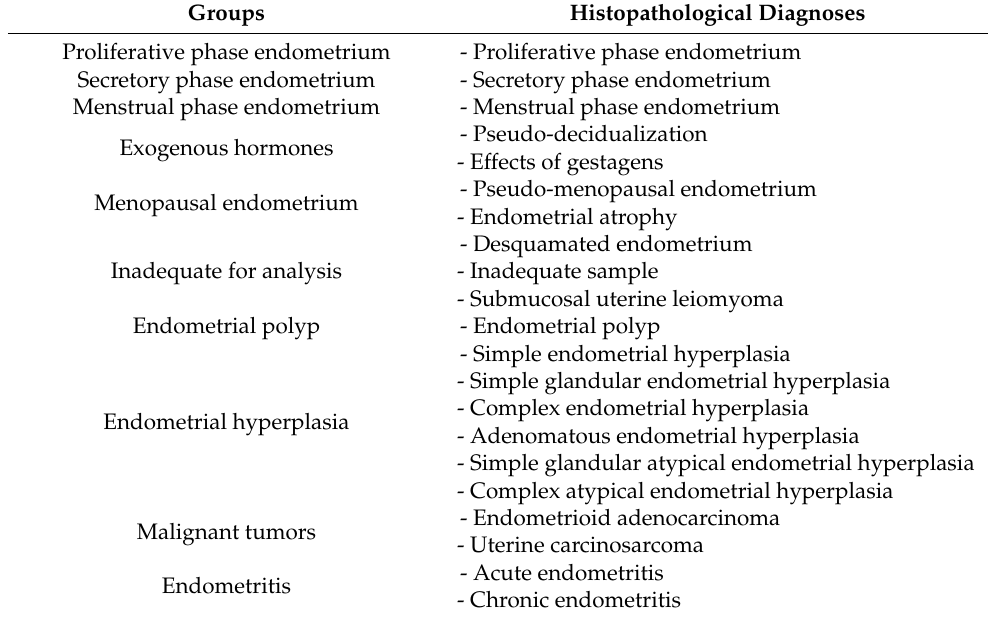
Table 1. 21 different histopathological diagnoses categorized into 10 groups.